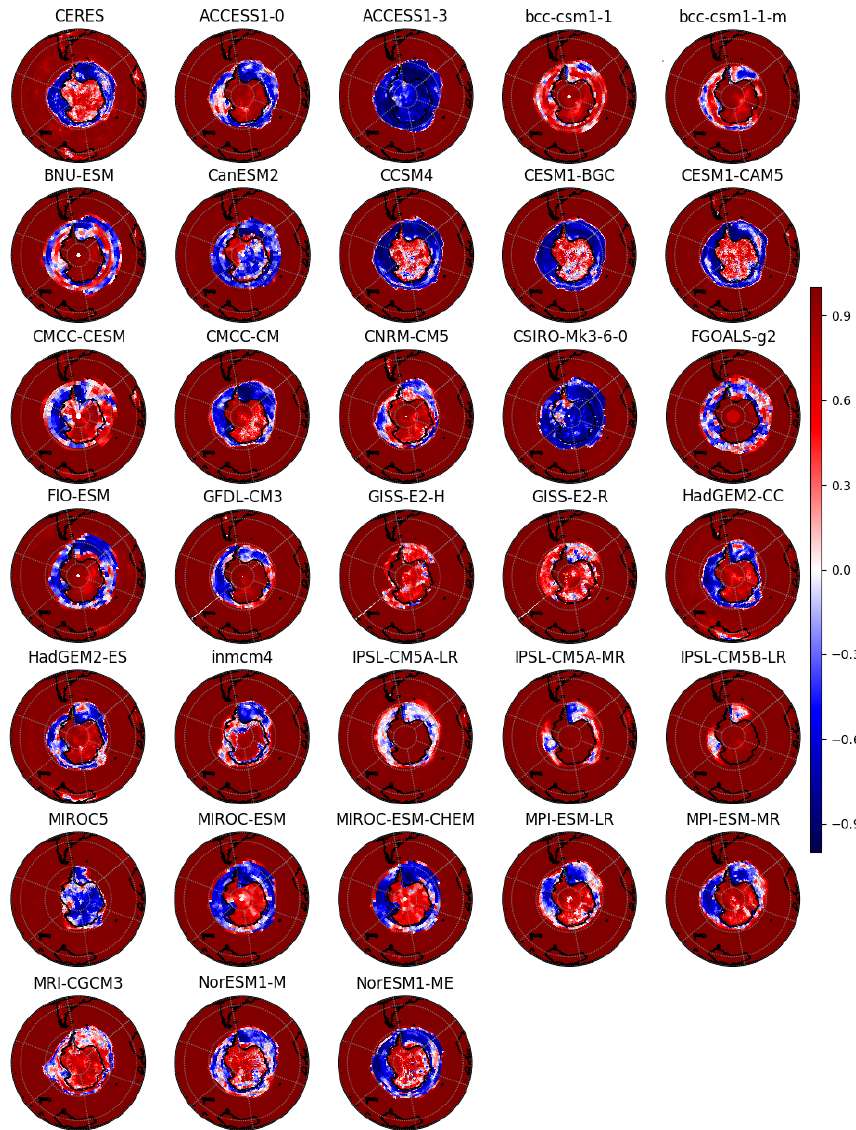
Figure 4. Correlation between SW cre and SW sfc shown by 32 CMIP5 Earth system models and CERES between 2001 and 2016 over the Southern